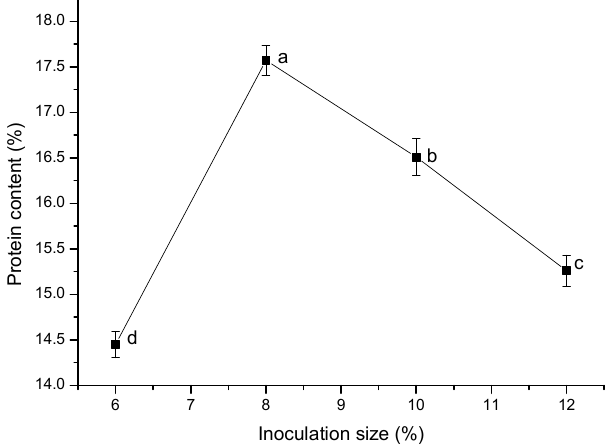
Figure 6. The single-factor experiments for inoculation size in the second stage of the solid-state fermentation. Experiments were performed in triplicate (n = 3). Sites not sharing a common letter showed significant differences ( p < 0.05).